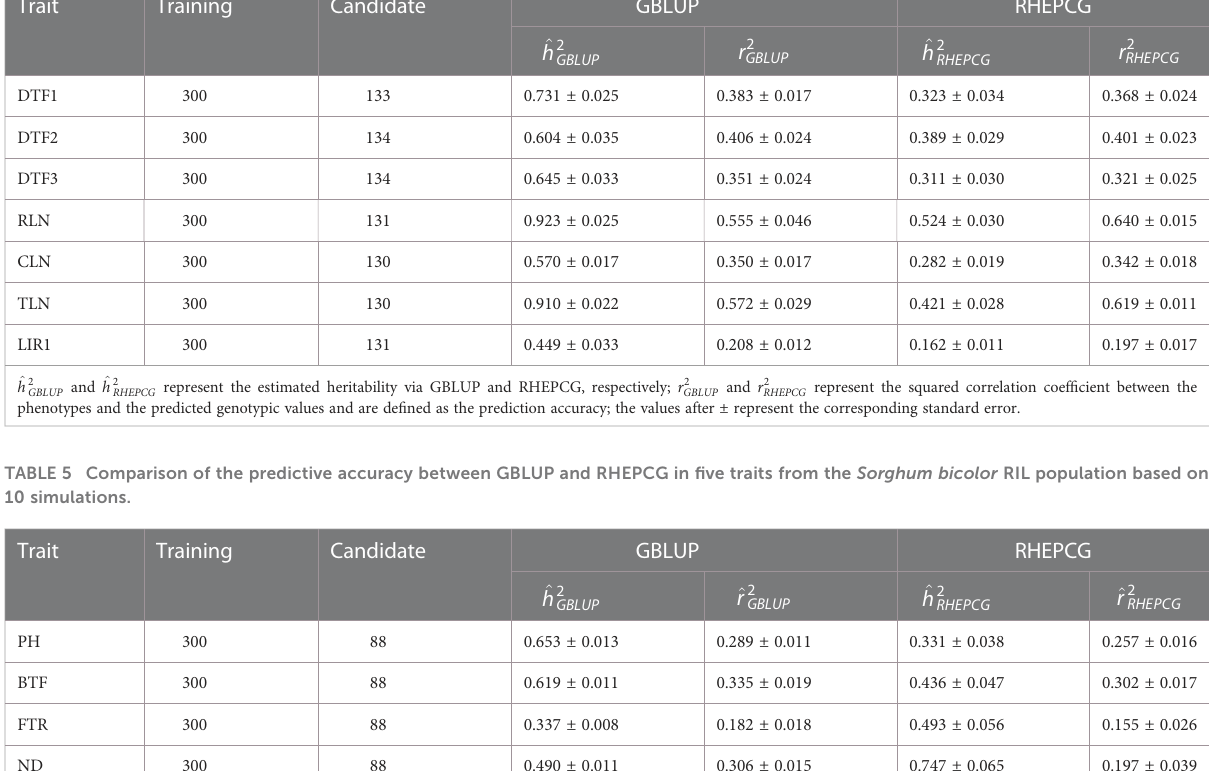
TABLE 4 Comparison of the predictive accuracy between GBLUP and RHEPCG in seven traits from the Arabidopsis thaliana F2 (P15) population based on 10 simulations. Trait